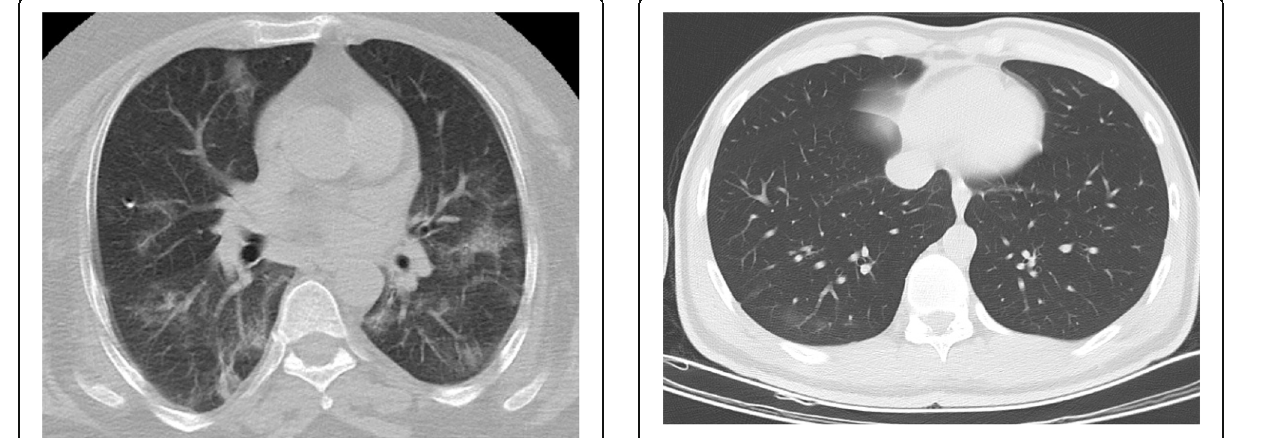
Fig. 3 Unifocal GGO in right lower lobe-CO-RADS 3. COVID-19 unsure or indeterminate